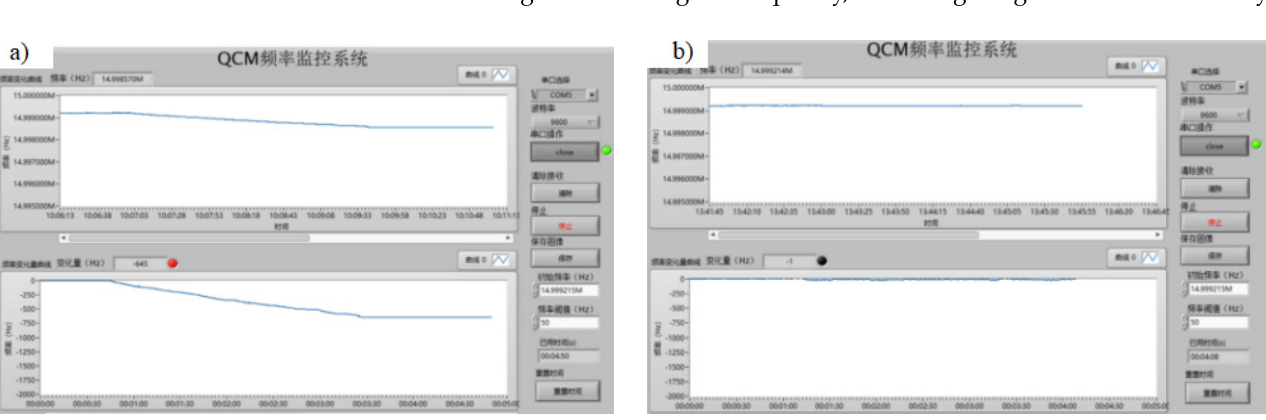
Figure 9. ( a ) Interface for testing RNA virus positive samples (The title of the diagram indicates: QCM frequency acquisition system.); ( b ) interface for testing negative RNA virus samples (The title of the diagram indicates: QCM frequency acquisition